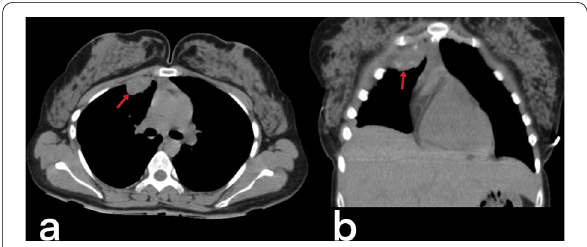
Fig. 18 Transverse ( a ) and coronal reformatted ( b ) CT images without contrast of a 24-year-old female. A mass-like focal pleural lesion in the right side containing a few coarse calcifications is noted. The patient is diagnosed with TB on histopathologic assessment after surgical removal of the mass